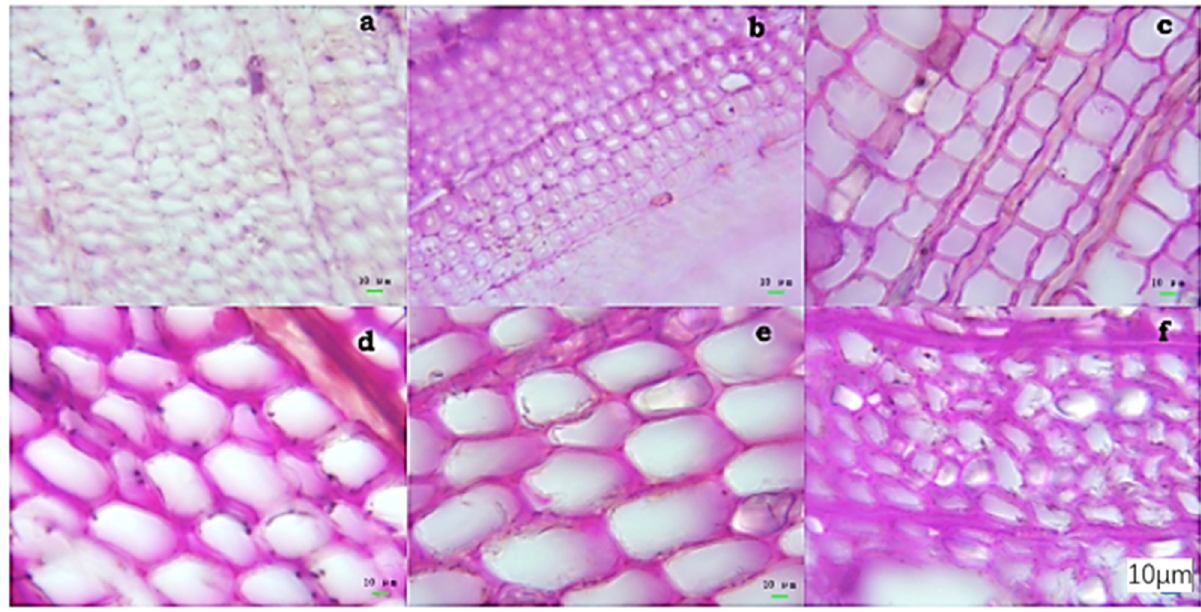
Figure 7: Light micrograph section of ( a ) untreated eucalyptus; ( b ) treated eucalyptus; ( c ) treated Chinese fi r; ( d ) untreated pine; ( e ) treated pine; and ( f ) poplar after burial for 377 days [ 68 ]